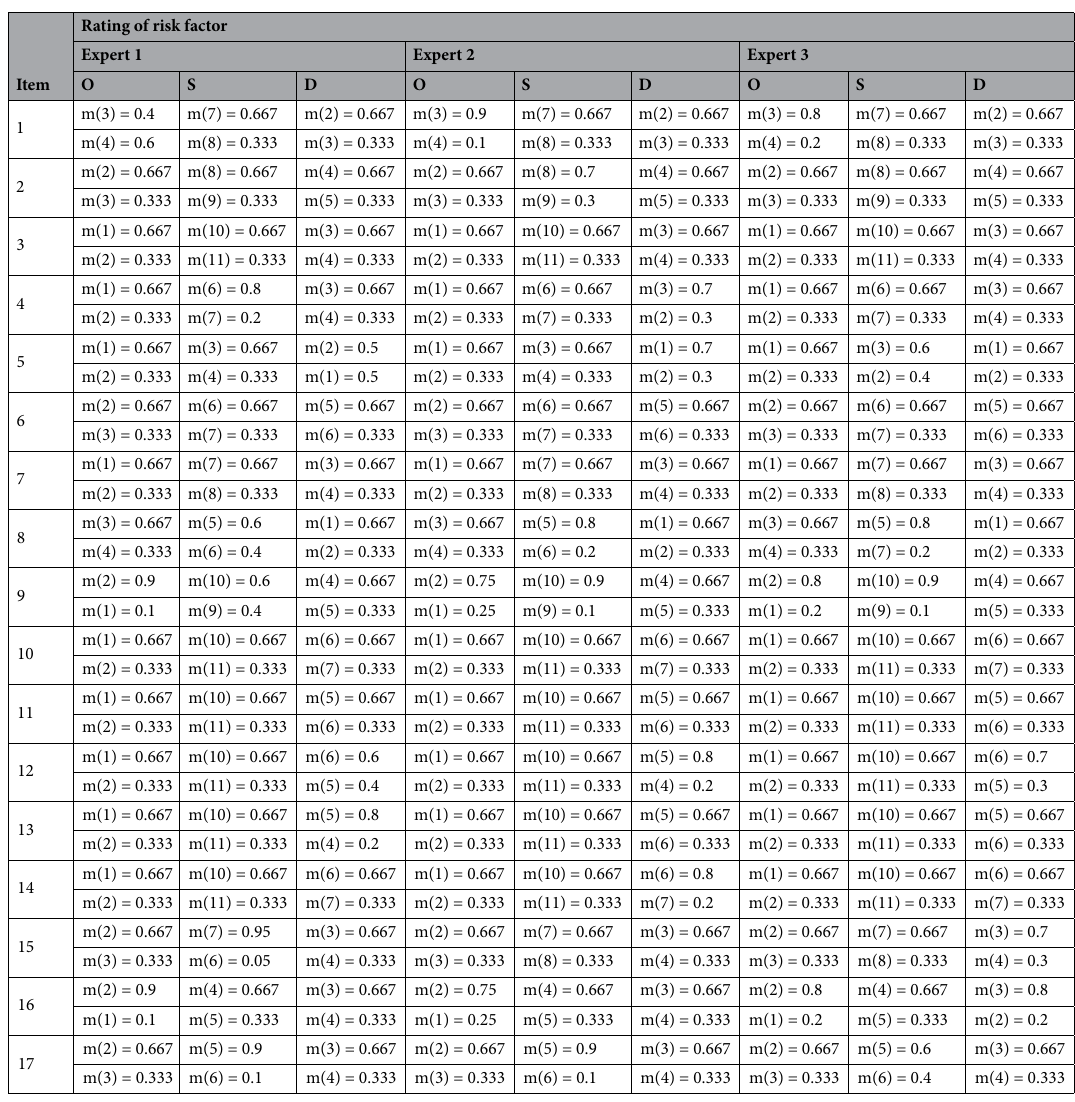
Table 1. BPAs constructed using triangular fuzzy numbers.